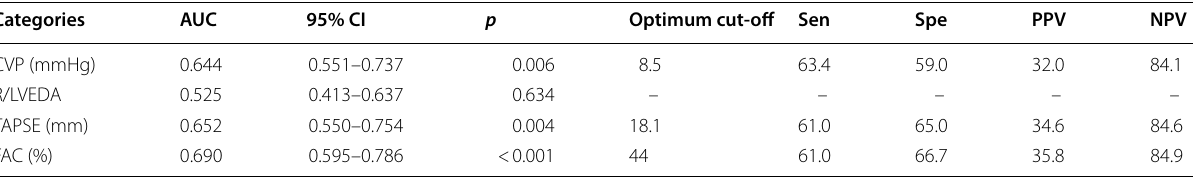
Table 2 ROC analysis of variables for the prediction of 30-day mortality